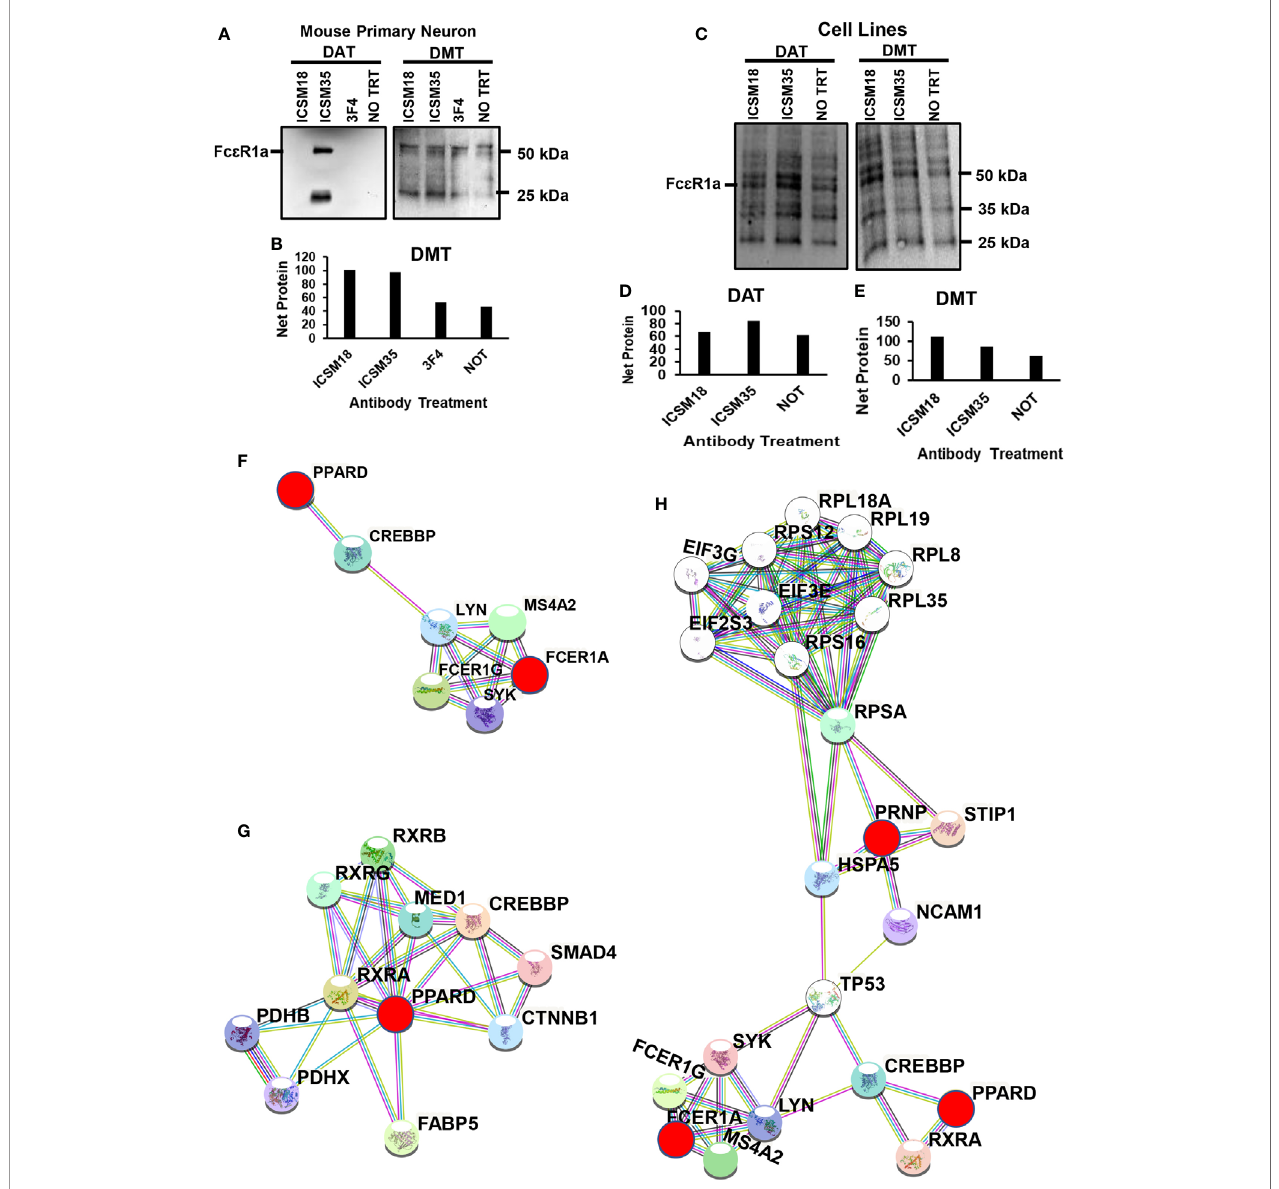
FIGURE 8 | Differential expression of Fc e R receptors following anti-PrP antibody treatment to mouse primary neuron cells and mouse neuroblastoma cell line. Western blotting of (A) direct antibody treatment (DAT) and direct microglia treatment (DMT) of mouse primary neuron cells (B) densitometry analysis of (A) . (C) DAT and DMT of mouse neuroblastoma cells (D, E) densitometry analysis of (F) . (F) protein-protein interaction of PPARD with Fc e R1a (G) Illustration of protein interactome with PPARD (H) Illustration of protein-protein interactions between PPARD, Fc e R1a and PrP C